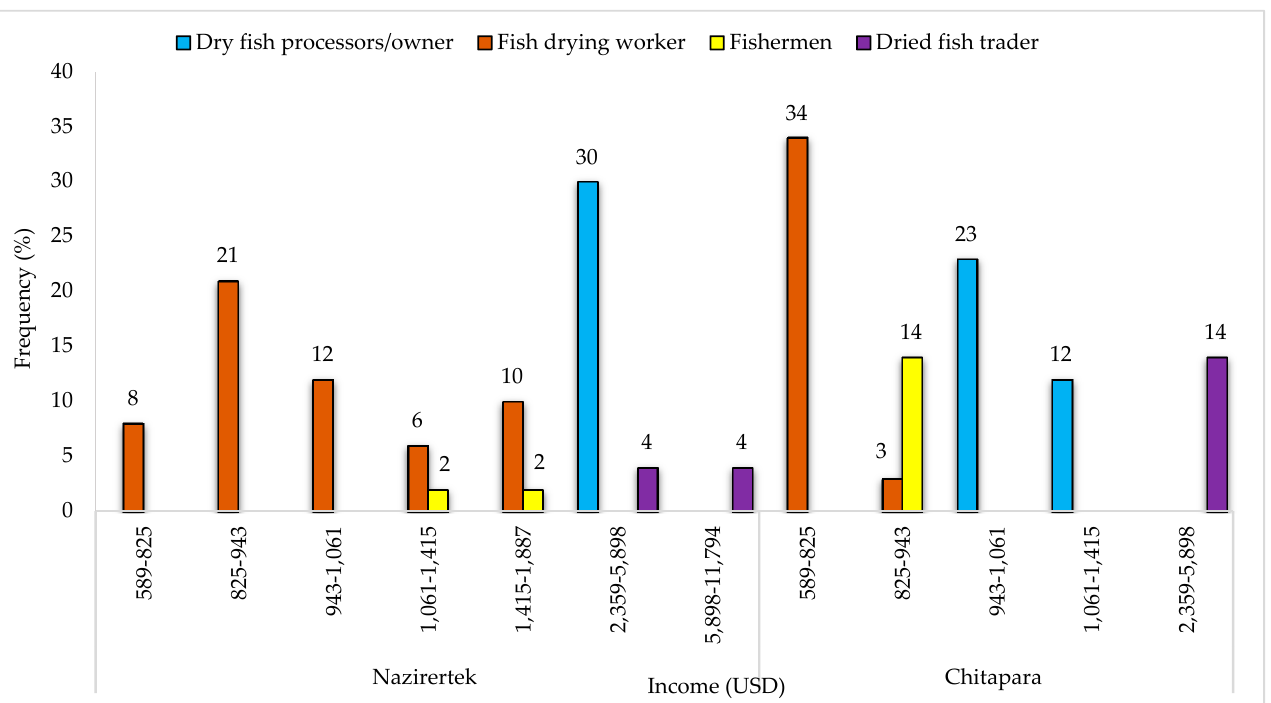
Table 4. Nutrition and food consumption ratio of the respondents of the studied areas.